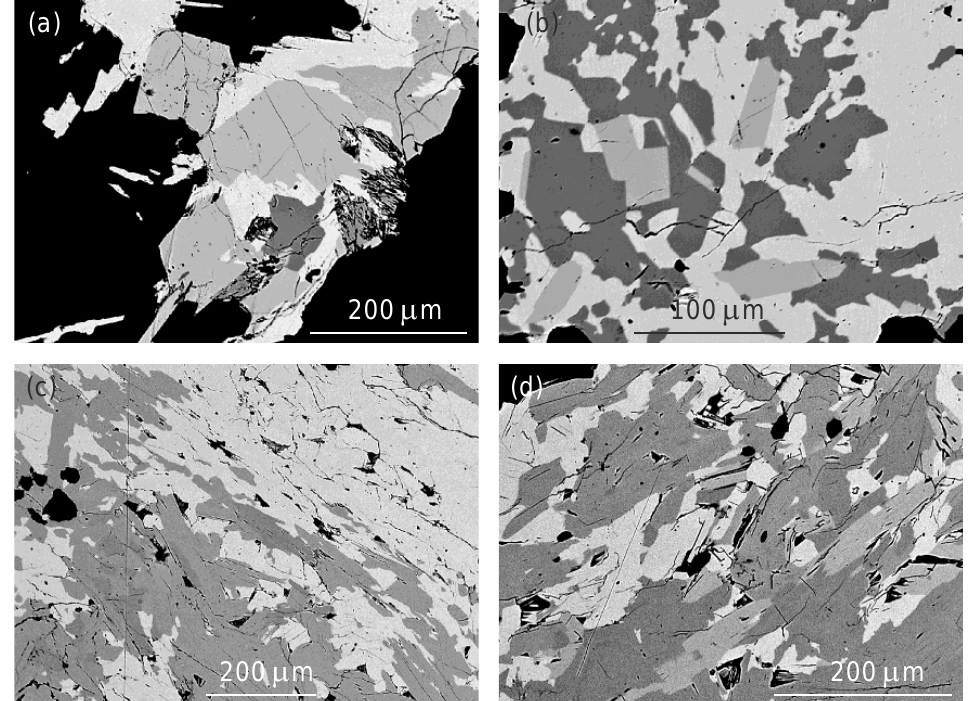
Figure 10. ( a ) Dadsonite (lighter grey) and rouxelite grains (darker grey) in boulangerite (white) with bournonite inclusion (dark); ( b ) the euhedral metacrysts of dadsonite (grey) in boulangerite (light) and bournonite (dark); ( c ) the relics of rouxelite (darker grey) in dadsonite aggregates (lighter grey) in association with boulangerite (white); ( d ) chovanite metacrysts (light grey) in dadsonite (lighter grey)—rouxelite (darker grey) aggregates with earlier boulangerite (white). BSE photos. Rouxelite occurs as rare irregular silvery grey, metallic, fibrous aggregates up to 2 cm in quartz gangue and as light grey aggregates up to 1 cm together with Table 2. Unit-cell parameters of dadsonite (for triclinic space group P -1). Kľačianka